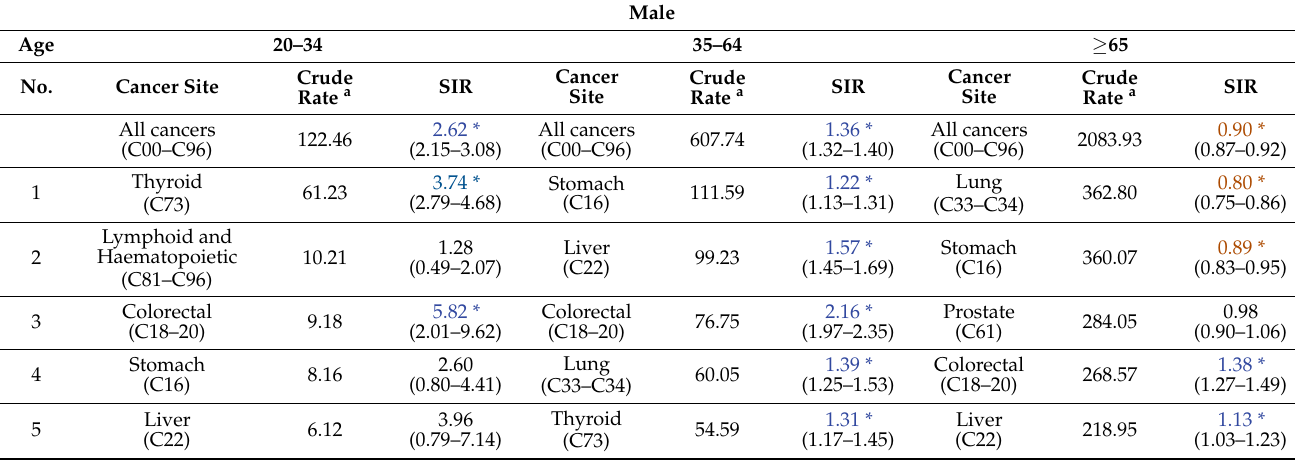
Table 3. Incidence rates of major cancers according to age in male patients who underwent cholecystectomy.